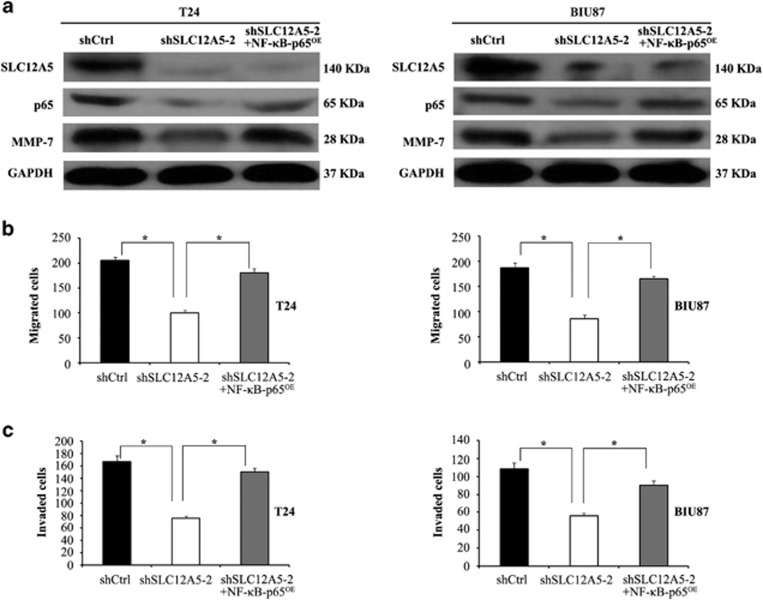
SLC12A5 promotes MMP-7 expression via NF-κB-dependent transcription. (a) Western blot analysis of the relative protein levels of SLC12A5, MMP-7 and NF-κB-p65 in three groups of ShCtrol, SLC12A5 ShRNA and SLC12A5 ShRNA co-treated with overexpression of NF-κB-p65 (NF-κB-p65OE) for both T24 and BIU87 stable cell lines. The overexpression of NF-κB-p65 rescued the downregulation of MMP-7 expression induced by SLC12A5 knockdown. (b and c) The decreased ability of migration and invasion regulated by SLC12A5 knockdown was rescuced by overexpression of NF-κB-p65 in both T24 and BIU87 stable cell lines. All experiments were carried out in triplicate. Histograms represent means±S.D.